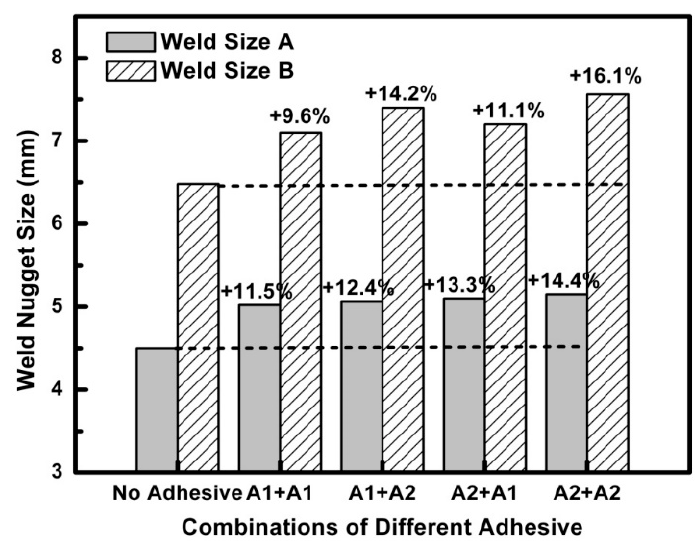
Figure 15. Weld nugget sizes of weld-bonding with Betamate Flex and Terokal 5089.